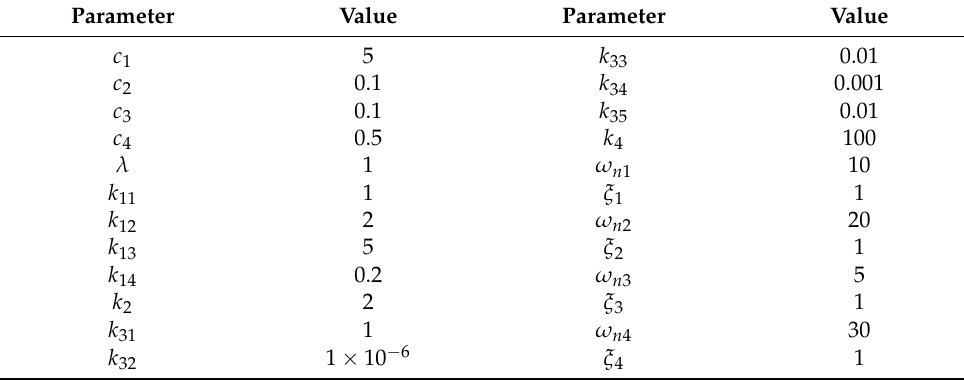
Table 2. Parameters of CFAC.